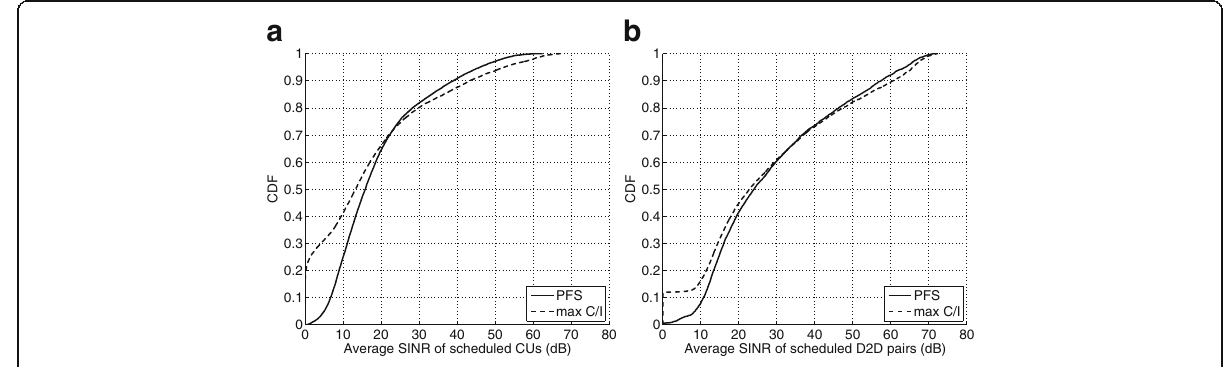
Fig. 5 CDF of average SINR for PFS and max C/I. a CUs. b D2D